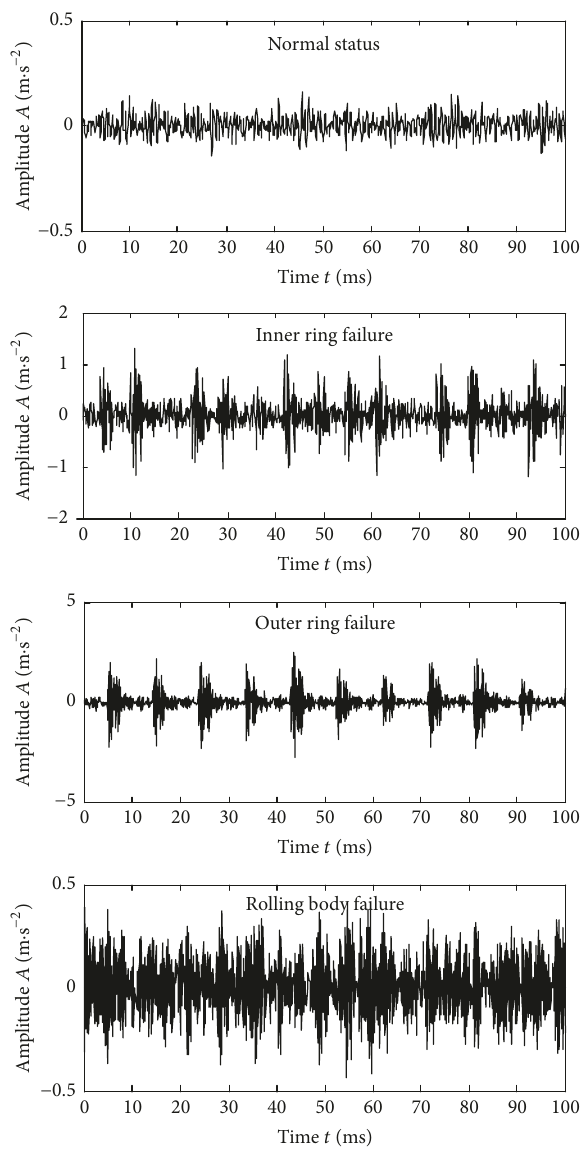
Figure 3: Vibration signals for four different types of